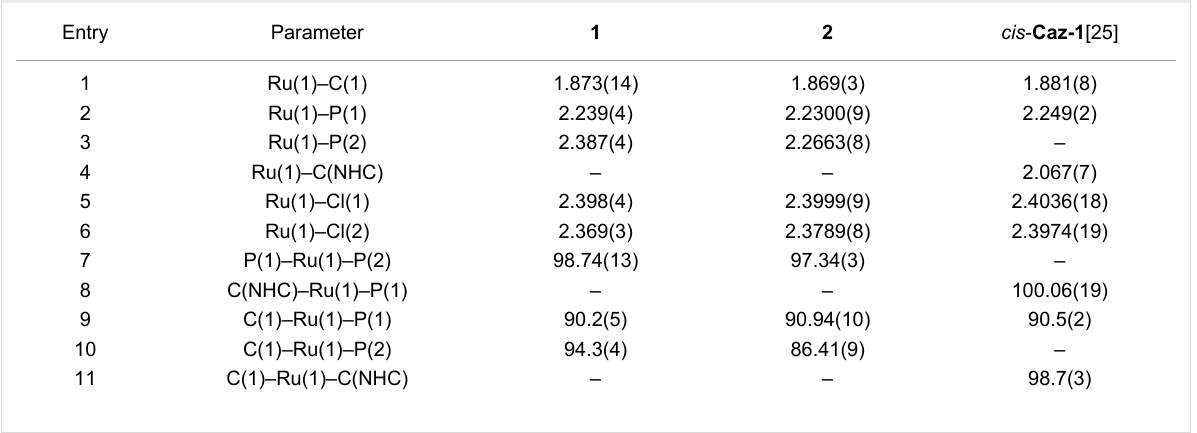
Table 1: Selected bond distances (Å) and angles (°) for 1 , 2 and cis - Caz-1